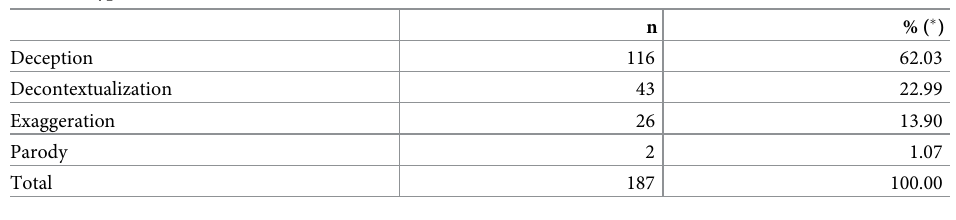
Table 8. Types of hoaxes.